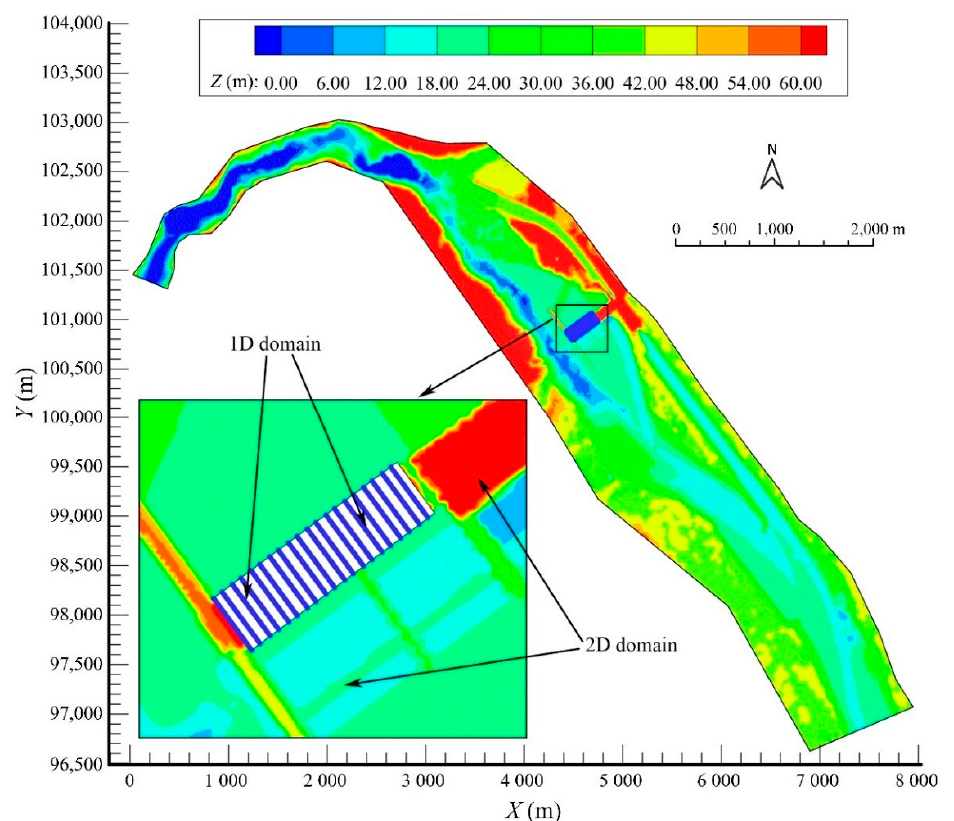
Figure 5. Layout of the 1D–2D coupled river closure model.